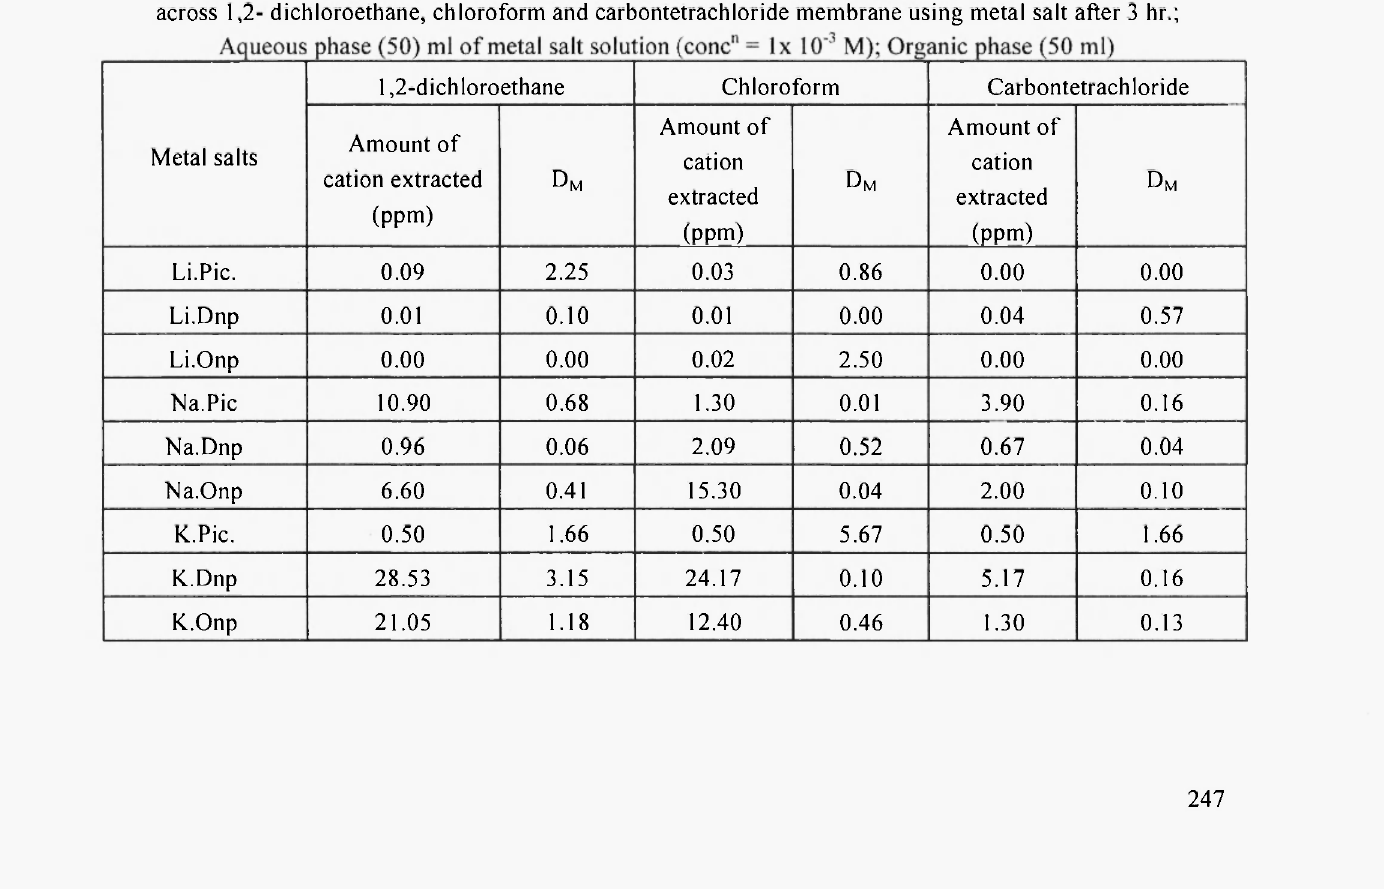
Amount of cation extracted by ionophore Triethyleneglycol bis(2-ethylhexanoate) and distribution ratio across 1,2- dichloroethane, chloroform and carbontetrachloride membrane using metal salt after 3 hr.;